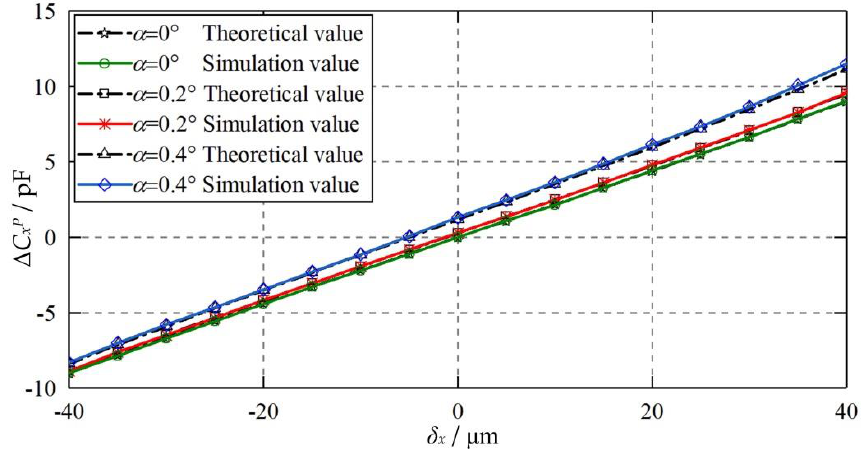
Figure 19. Dependence of the differential capacitance Δ C xP on the eccentric displacement of the ball when CP S1 is inclined with an angle to the ideal position.